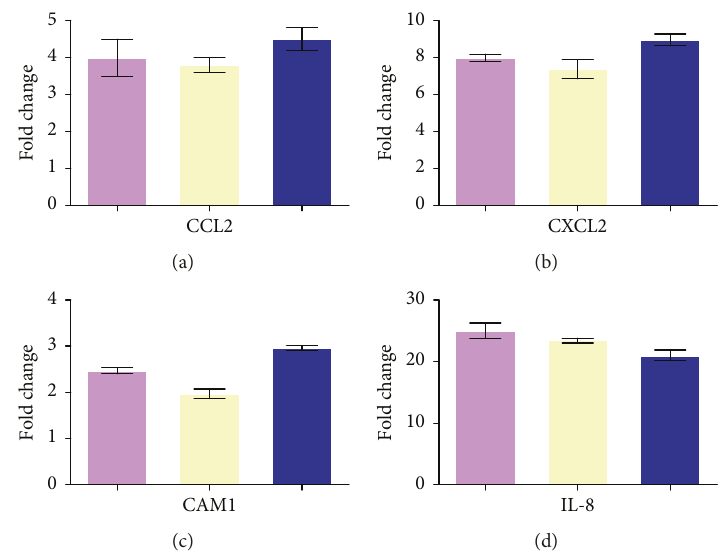
Figure 3: Real-time RT-PCR of some modulated genes con fi rms the results of gene array analysis. Genes selected for validation were CCL2, CXCL2, ICAM1, and IL-8. All the transcripts were increased in BD samples when compared to healthy donors. Relative expression levels were calculated for each sample after normalization against the housekeeping genes 18s rRNA, beta-actin, and GAPDH. Experiments have been conducted in triplicates. Housekeeping genes: violet bar: 18s rRNA; yellow bar: beta-actin; and blue bar: